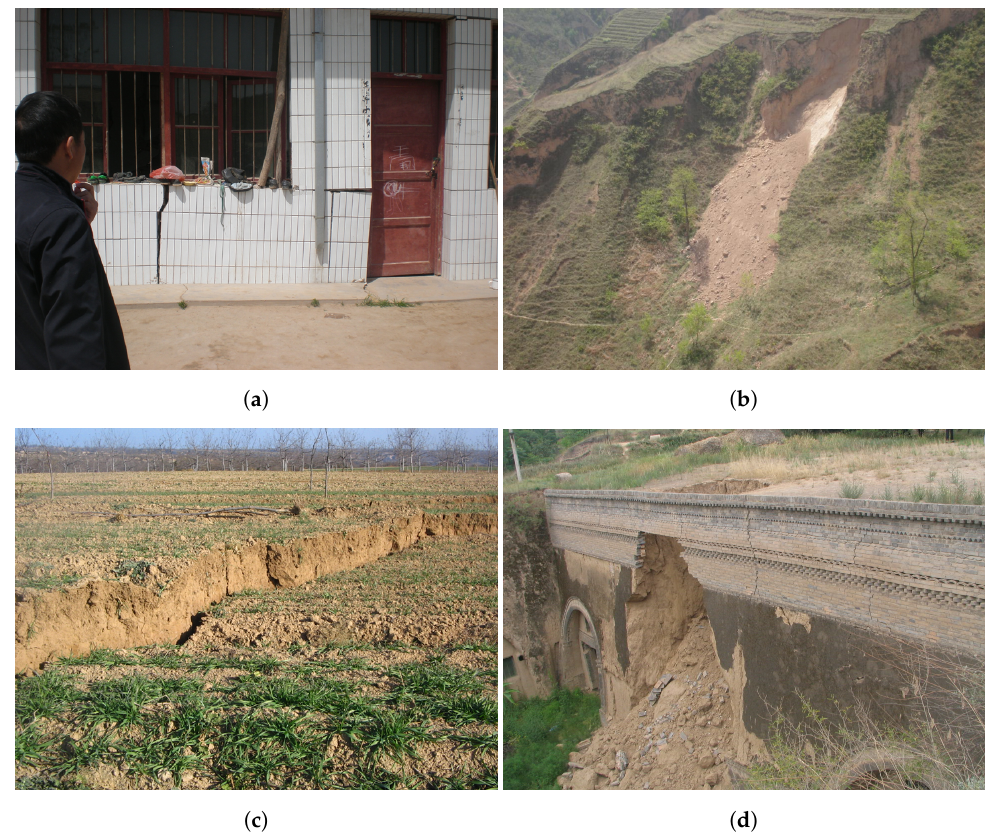
Figure 2. Deformation and subsidence cause by underground coal mining. ( a ) Building deformation; ( b ) landslide; ( c ) ground cracks; ( d ) ground